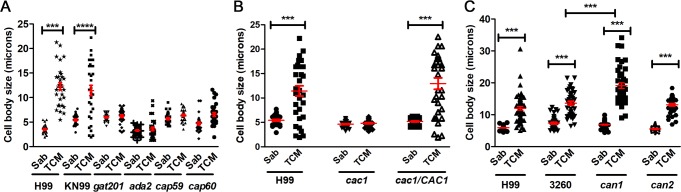
Titan-like cell formation in different mutants.(A) Cells from the capsule deficient mutants gat201, cap59, cap60 and ada2 (H99 background) were inoculated in Sabouraud and TCM medium at a density of 104 cells/mL in 96-well plates. Cell body size was determined after overnight incubation at 37°C with CO2. (B) Role of adenylate cyclase on cell growth of C. neoformans. Cells from the wild-type strain H99, the adenylate cyclase mutant (cac1) and the reconstituted strain (cac1/CAC1) were incubated as described above. (C) Role of carbonic anhydrases on cell growth. Cells from the wild type strain H99 and KN99 (3260) and the can1 and can2 mutants were used for this purpose. Cell body size was determined after overnight incubation at 37°C with CO2 in all cases. The asterisks indicate significant differences (see M&M). The red lines represent the mean and standard error.